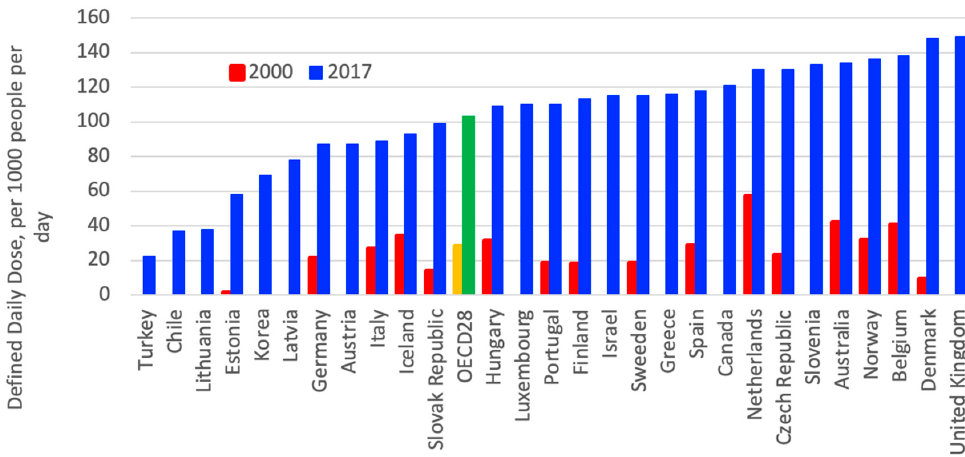
Figure 7. Consumption of cholesterol-lowering drugs in Organization for Economic Cooperation and Development (OECD) countries from 2000 to 2017 [3].